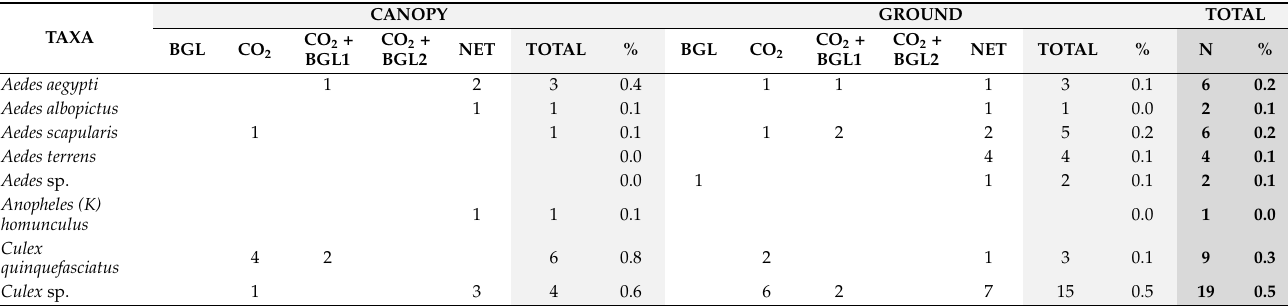
Table 1. Number of female specimens collected by genus and species, according to stratum (canopy and ground) and capture technique (treatment) between October 2019 and March 2020. Guarulhos, SP,